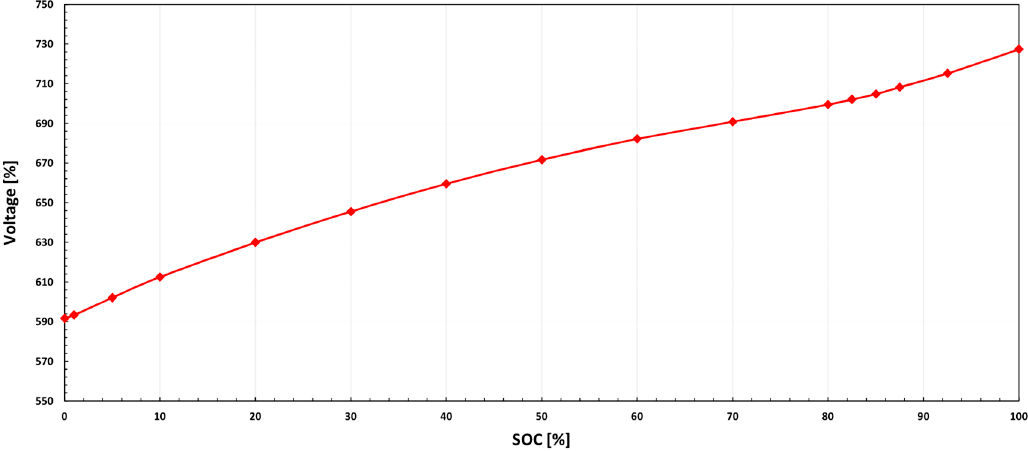
Figure 12. State of charge (SOC) of the battery pack.